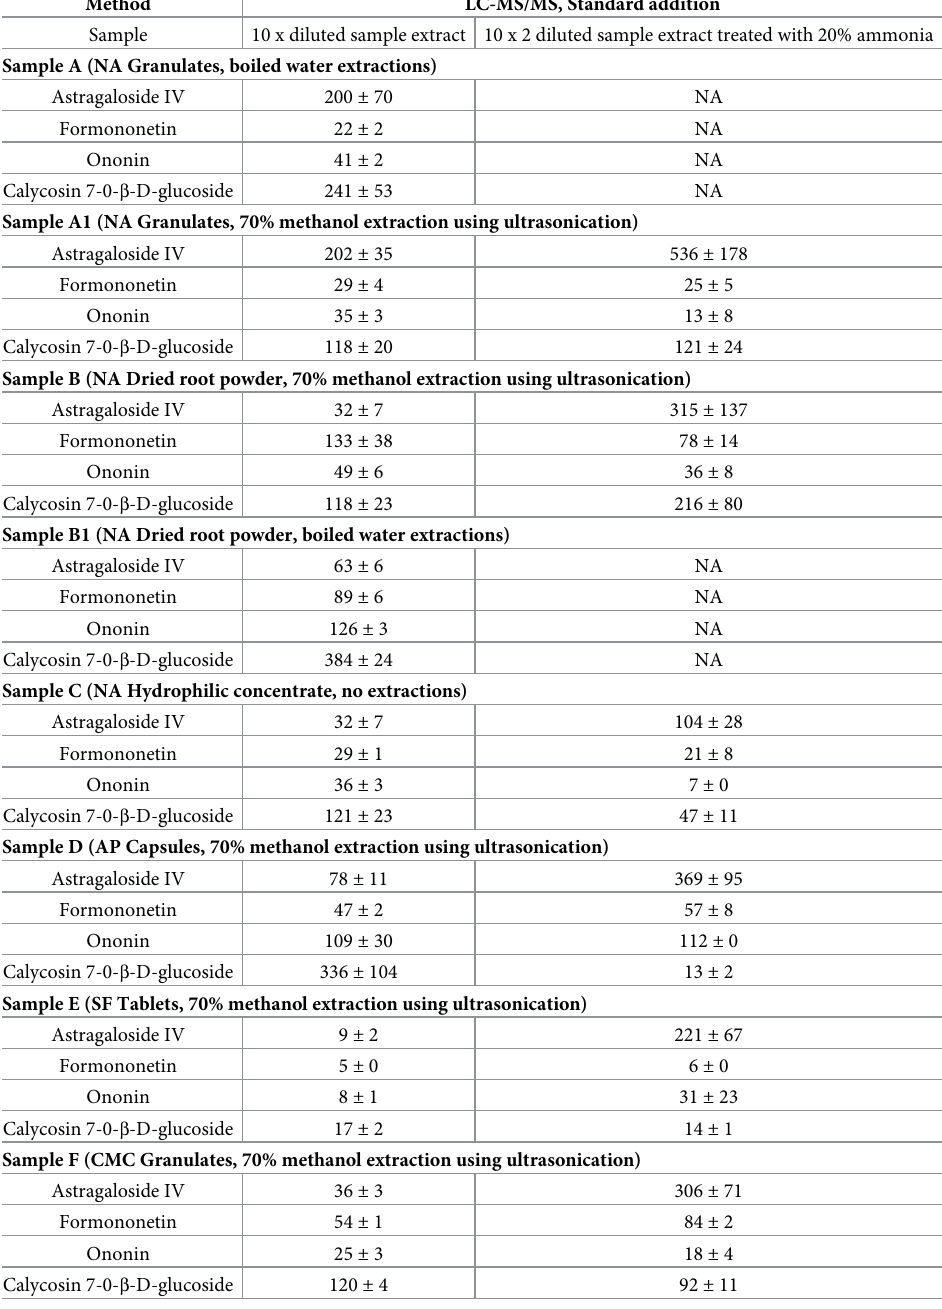
NA = Not Analysed, Sample E (Tablets from Seven Forest contained 12% of astragalus root per 1 g